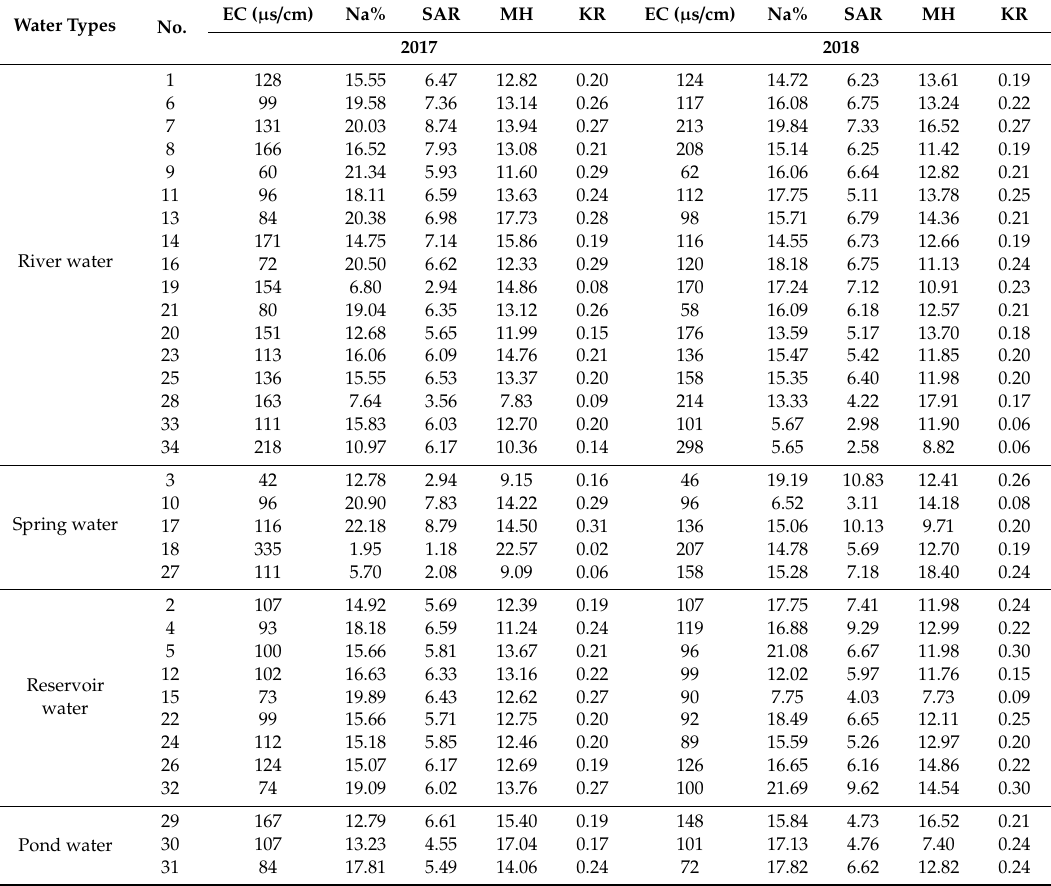
Table 4. Electrical conductivity (EC), Na%, sodium absorption ratio (SAR), magnesium hazard (MH), and Kelly’s ratio (KR) values of water samples in the